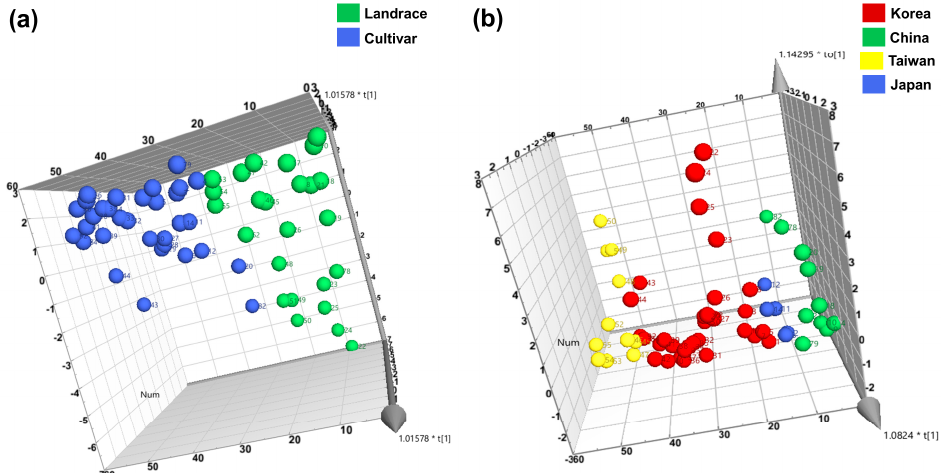
Figure 5. 3D Orthogonal projections to latent structure discriminant analysis (OPLS-DA) score plots of Chinese cabbage germplasms. The score plot was clustered based on status (cultivar or landrace) and origin (Korea, China, Taiwan, and Japan). Clustered into two statuses ( a ); and four origins ( b ); respectively.